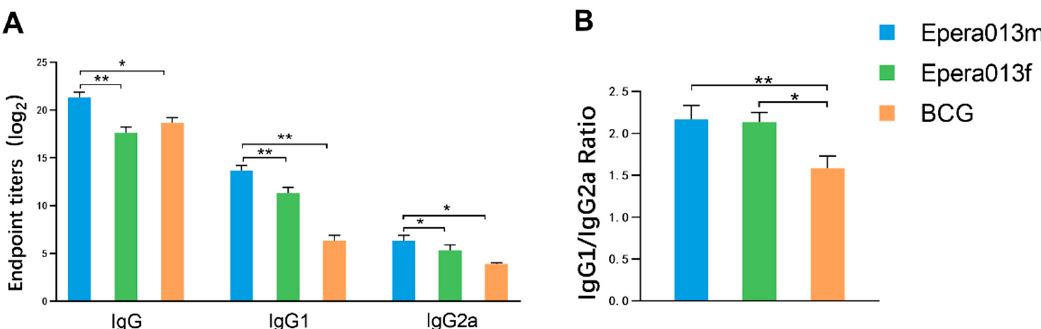
Figure 4. Comparison of serum antibody levels of immunized mice among the Epera013f, Epera013m and BCG groups ( n = 6 for each group, mean values ± S.E.M.). ( A ) Endpoint titers of serum IgG and two isotypes IgG1 and IgG2a in Epera013f, Epera013m and BCG groups. ( B ) Serum IgG1/IgG2a ratio of immunized mice in Epera013f, Epera013m and BCG groups. Values were from 3 independent experiments. One-way ANOVA followed by LSD (Least Significant Difference) mul- tiple comparison test was performed for the comparison among Epera013f, Epera013m and BCG groups (* p < 0.05, ** p < 0.01).